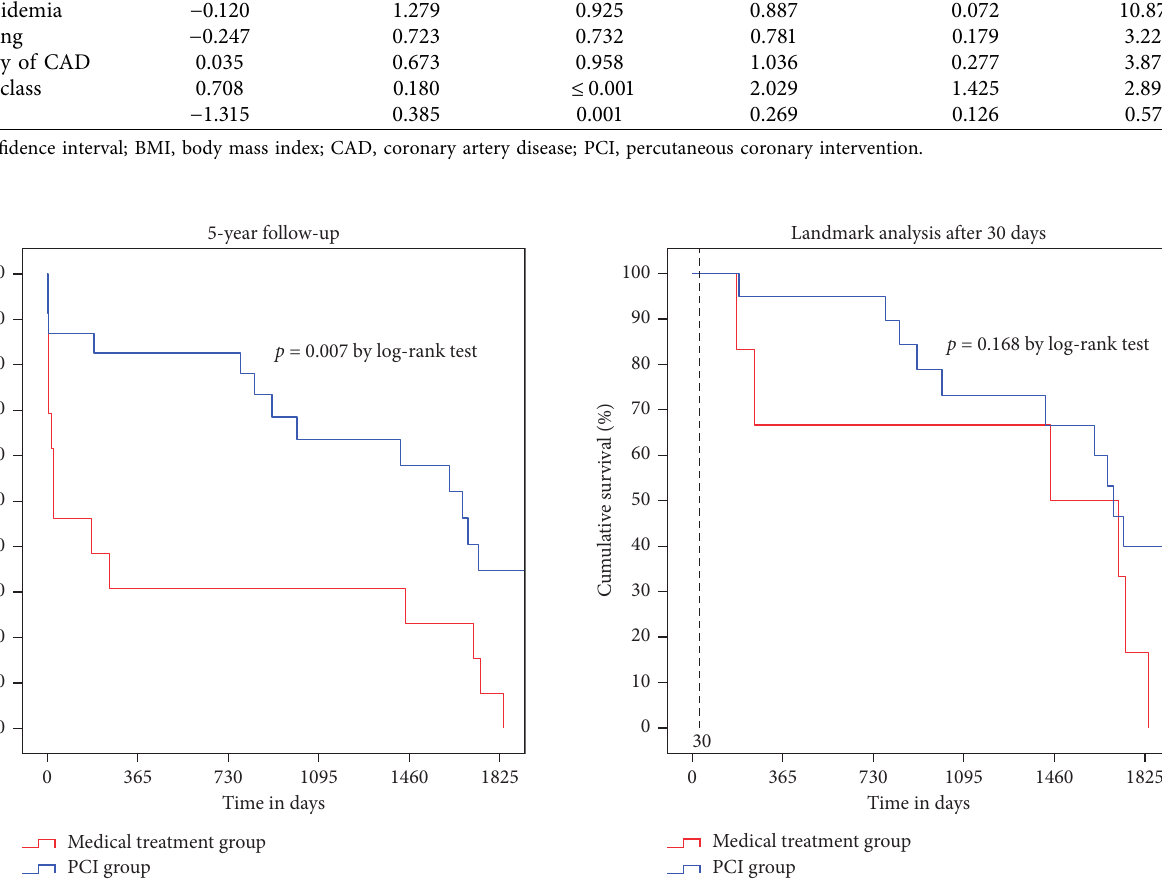
Figure 3: Kaplan–Meier curves of survival in the PCI group and medical treatment group, excluding Killip class 4 patients.